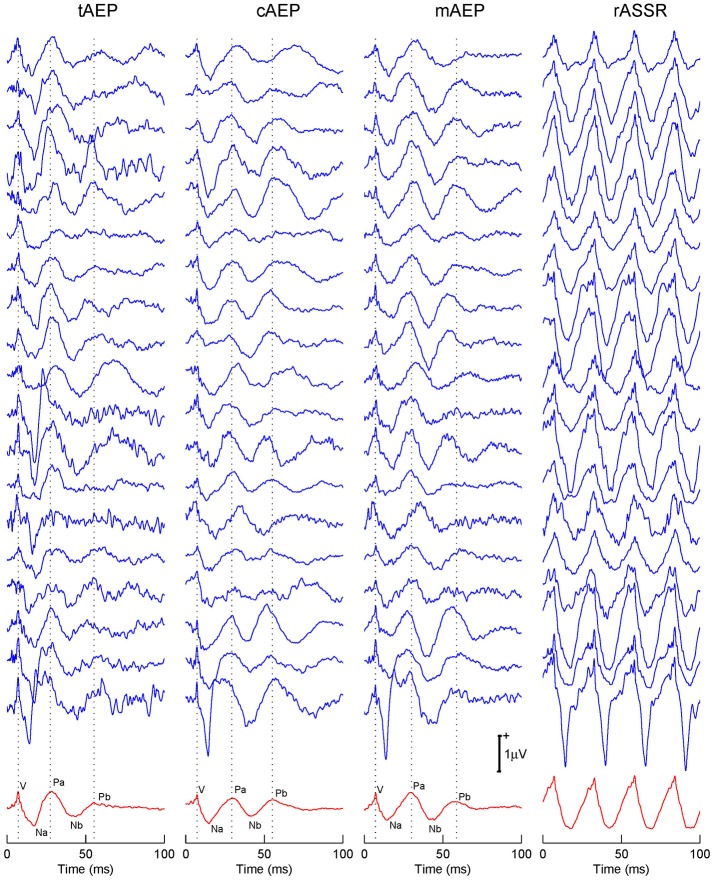
Individual and grand averaged tAEPs, cAEPs, mAEPs, and rASSRs. Sturdy characteristic components (i.e., V in ABR, Na, Pa, Nb, and Pb in MLR) present in the averaged AEPs shown in the bottom row. Three dotted vertical lines label the peaks of V, Pa, and Pb components.